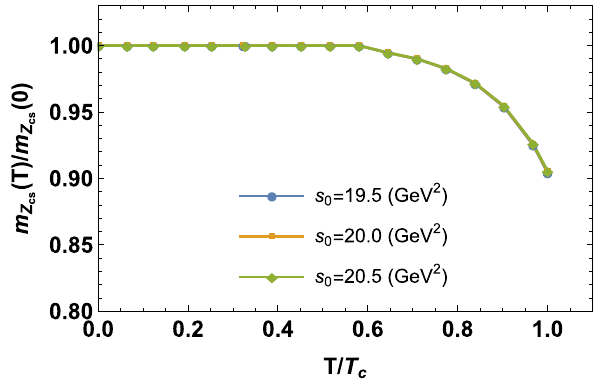
Fig. 2 The ratio of the temperature-dependent mass to vacuum mass of the Z cs state, respectively, in the tetraquark picture for fixed values of s 0 ( 0 )